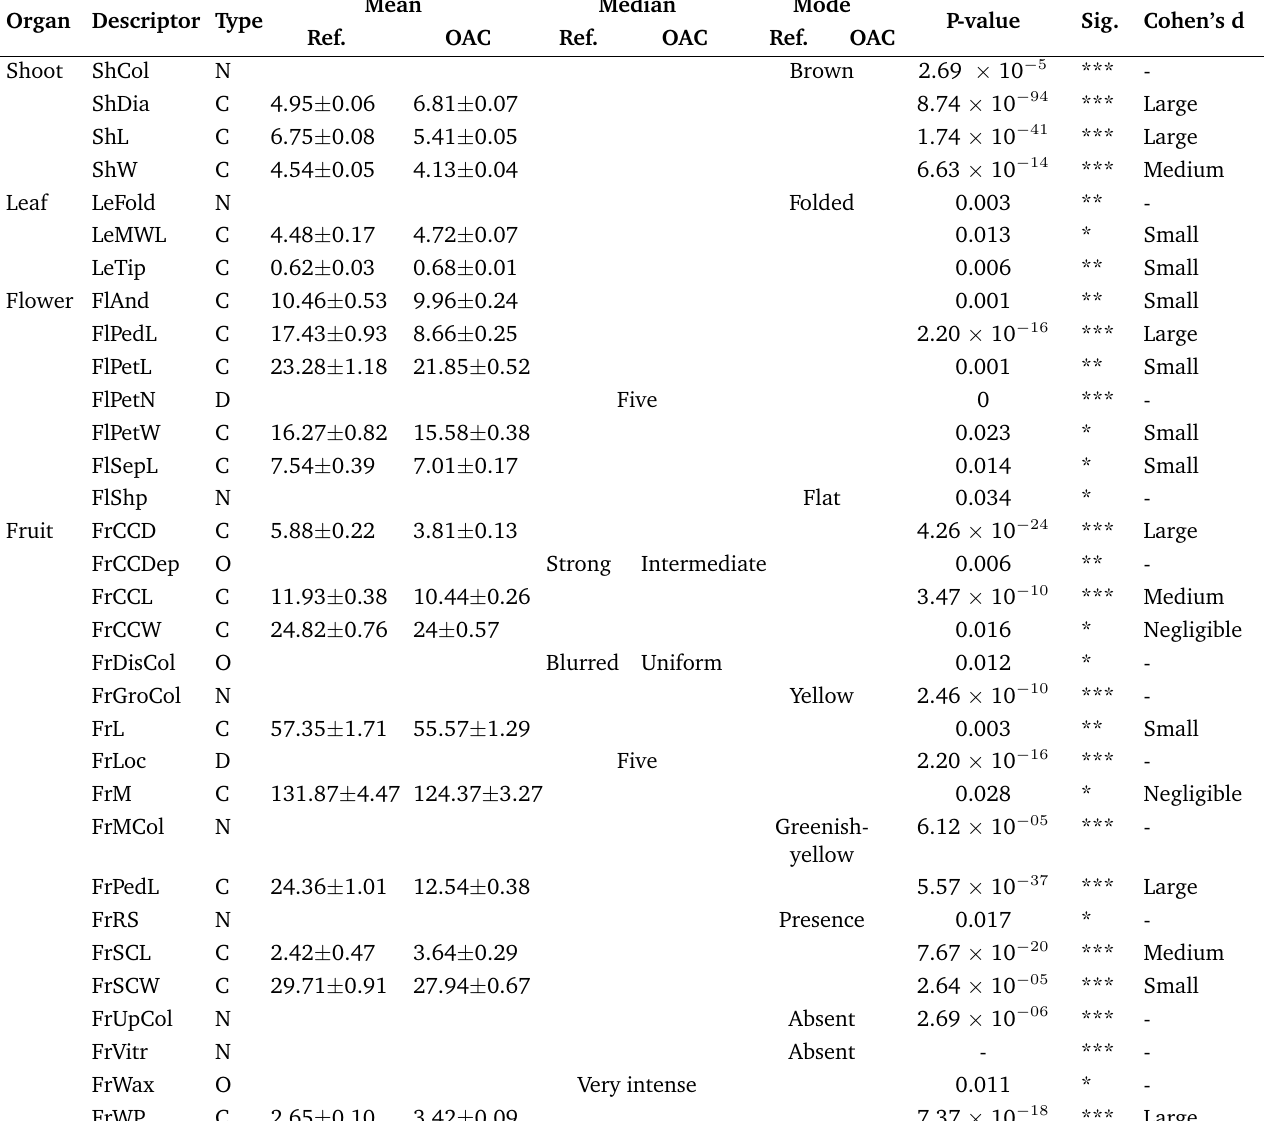
Table 4. Central statistics of the 32 significant descriptors analyzed by type of cultivar (references and old apple cultivars). Descriptor codes are as used in Table 3. C, continuous; D, discrete; N, nominal; O, ordinal; Ref., reference cultivar; OAC, old apple cultivar; Sig., significance; ***, P ≤ 0.001; **, P ≤ 0.01; *, P ≤